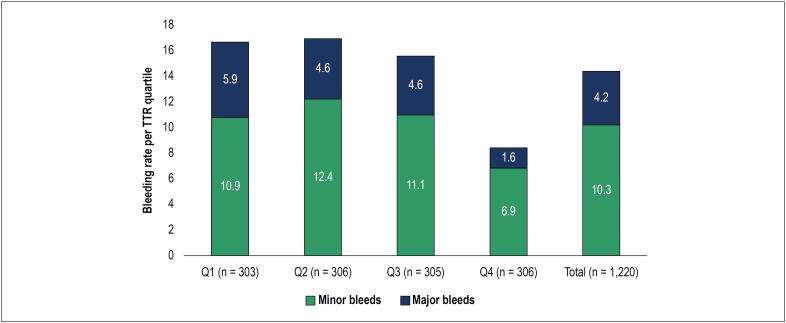
Bleeding rate per TTR quartile.